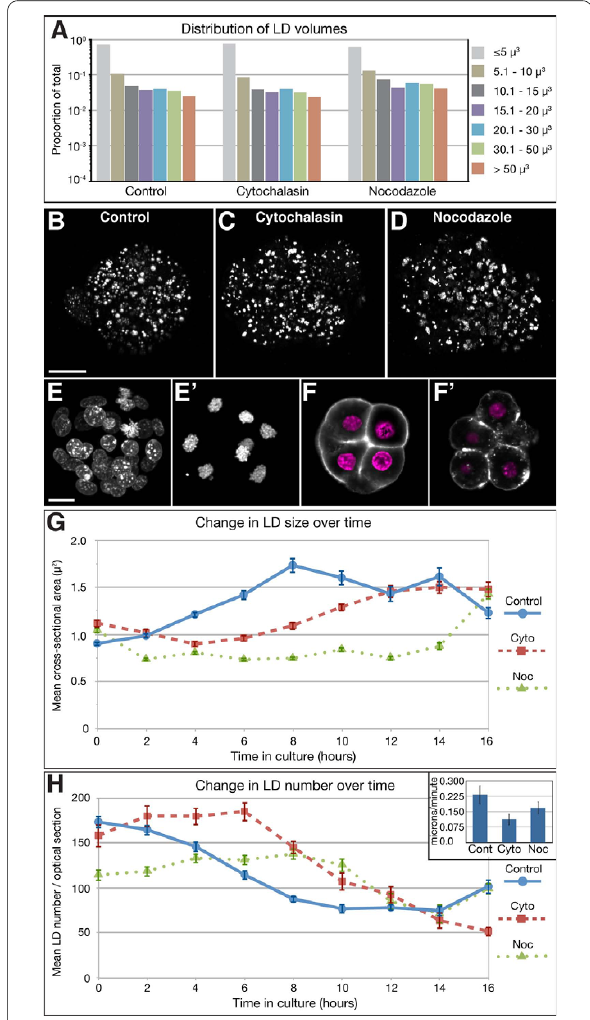
Figure 5 Dynamic behaviour of LD is both microtubule and mi- crofilament dependent . (A) LD size distribution in embryos after cul- ture for 22 hours in cytochalasin D and nocodazol. Control embryos were cultured in DMSO (carrier). There is no difference in the distribu- tion of LD sizes (n = 4 embryo for each condition). (B, C, D) Extended focus projections of THG signal from representative control, Cytocha- lasin D and Nocodazole treated embryos, showing no obvious differ- ence in LD. (E, E') Extended focus projections of confocal scans of fluorescence from DAPI stained nuclei (magenta) in control (E) and no- codazole (E') treated embryos. As expected, nuclei in the later are ar- rested at the metaphase stage, as seen by the condensed chromosomes. (F, F') Optical confocal section of fluorescence from F- actin stained with Phalloidin (grey) and nuclei stained with DAPI (ma- genta), in control and cytochalasin D treated embryos. As expected, F- actin localisation is disrupted in the latter. (G, H) Change in average LD size and number over time in embryos cultured in the presence of cy- tochalasin D and nocodazole (n = 12 sections from 4 embryos for each condition). Both inhibitors cause a clear delay in the formation of larger LD. The inset in (H) shows the estimated average velocity of LD. Treat- ment with the two inhibitors causes a significant reduction to LD ve- locity as compared to control LD (p < 0.0001, Students T-test). Scale bar in (B) = 20 μm and applies to (B, C and D). Scale bar in (E) = 20 μm and applies to (E, E', F and